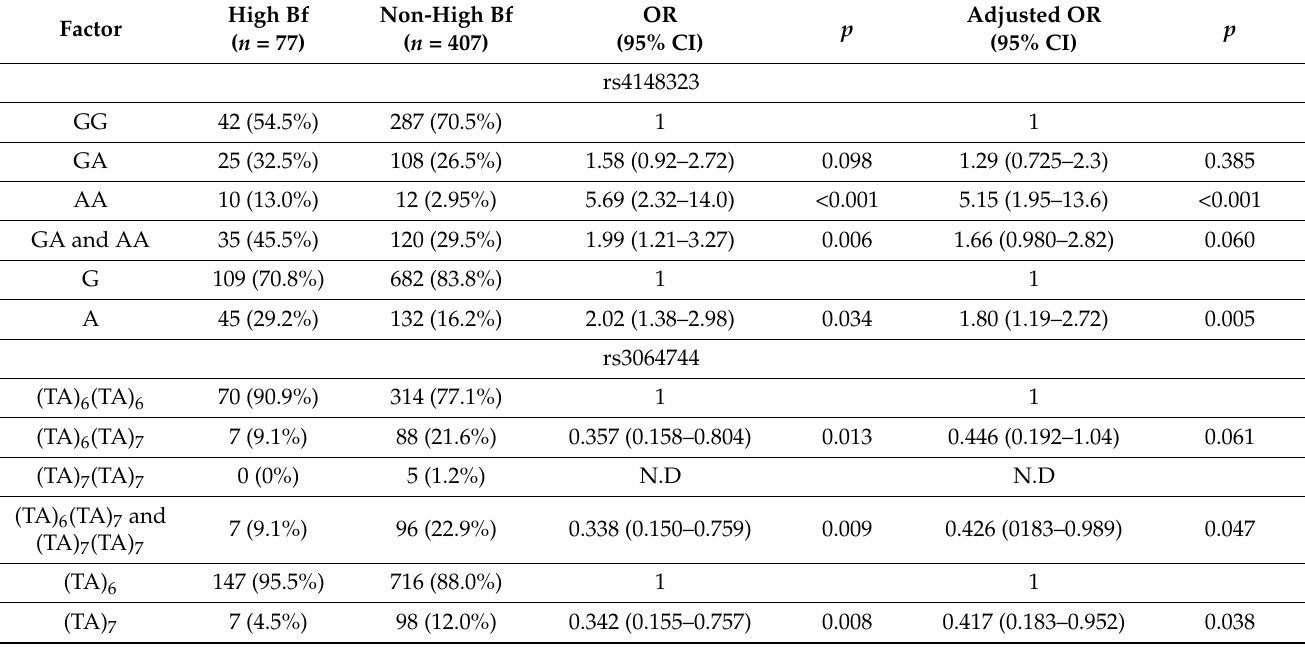
Table 3. Multivariable Logistic Regression